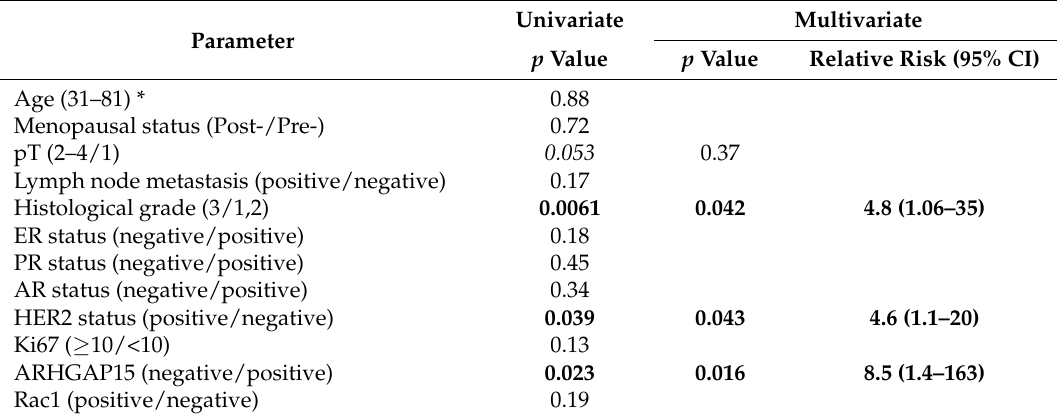
Table 4. Univariate and multivariate analyses of breast-cancer-specific survival in breast carcinoma patients ( n = 100). Univariate Multivariate Parameter p Value p Value Relative Risk (95%